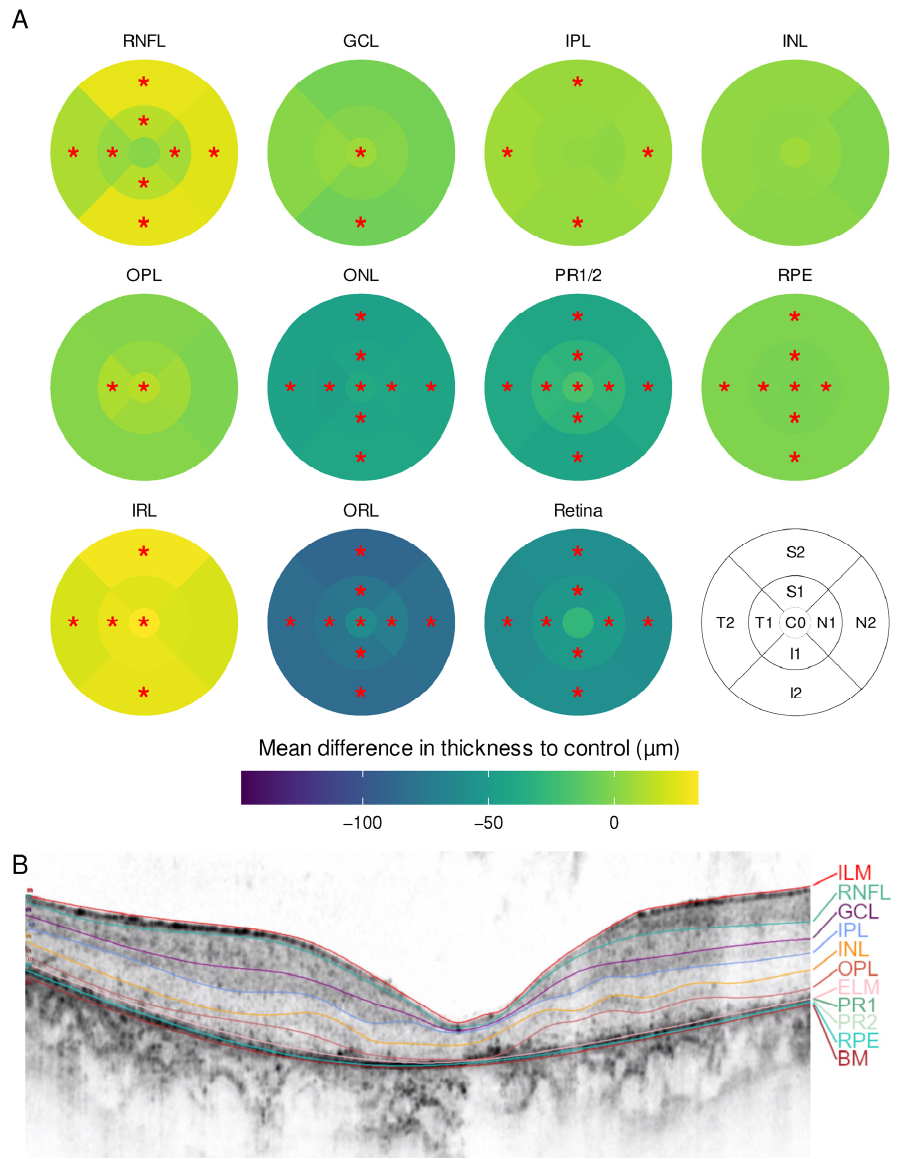
Figure 1. ( A ) Mean difference in layer thickness for Retinitis pigmentosa (RP) compared to controls represented as a heatmap on the ETDRS grid. Significant differences are marked with a red star (*) in the particular subfield. RNFL = retinal nerve fiber layer, GCL = ganglion cell layer, IPL = inner plexiform layer, INL = inner nuclear layer, OPL = outer plexiform layer, ONL = outer nuclear layer, PR1/2 = photoreceptor layer 1 and 2, RPE = retinal pigment epithelium, IRL = inner retinal layers (including RNFL, GCL, IPL, INL and OPL), ORL = outer retinal layers (including ONL, PR1/2, RPE); ( B ) example for a manually segmented SD-OCT scan from the fovea from RP patient 24.